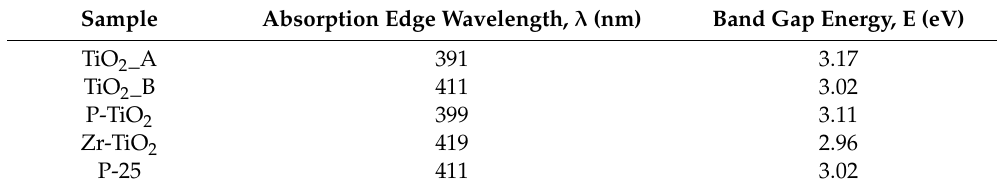
Figure 6. (DR)UV-Vis spectra of the studied sample: pure titania samples (( A ) Kubelka (cid:44) Munk plot and ( B ) Tauc’s plot) and doped samples (( C ) Kubelka–Munk plot and ( D ) Tauc’s plot). Table 3. Band gap energy (eV) and the absorption edge wavelength (nm) of the synthesized samples.